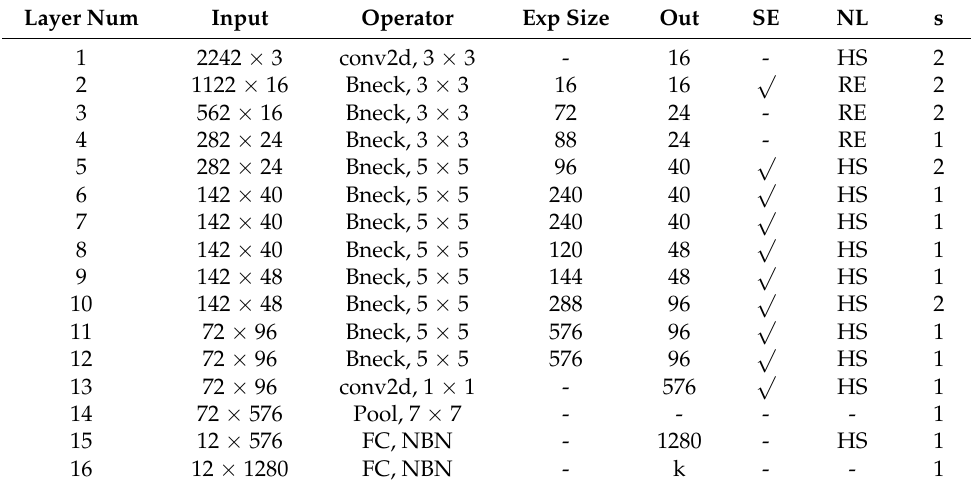
Table 2. Core module construction of MOBILENETS. Layer